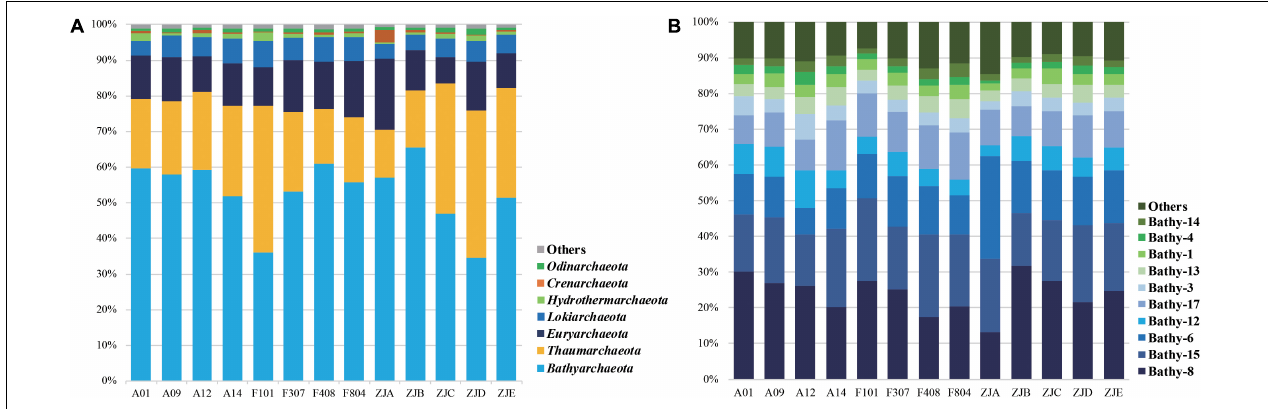
FIGURE 2 | Archaeal community composition on the phylum level (A) and major bathyarchaeotal (B) subgroup composition (average abundance fraction >